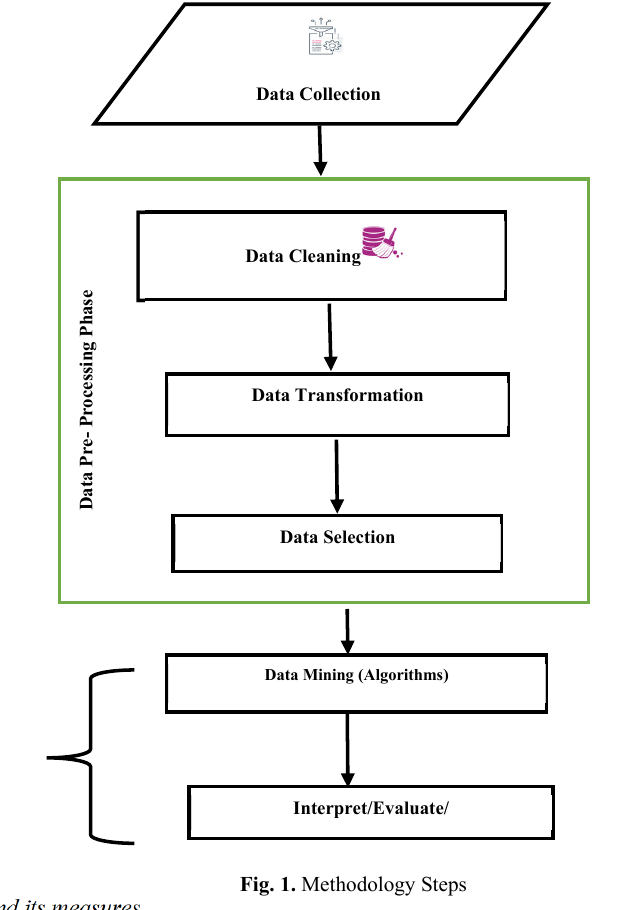
Fig. 1. Methodology